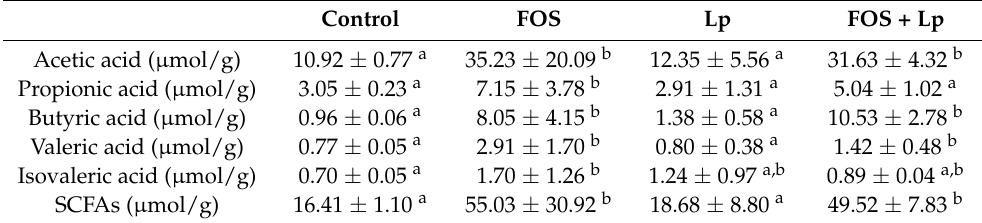
Table 1. The cecal SCFAs concentrations were analyze by GC-MS.